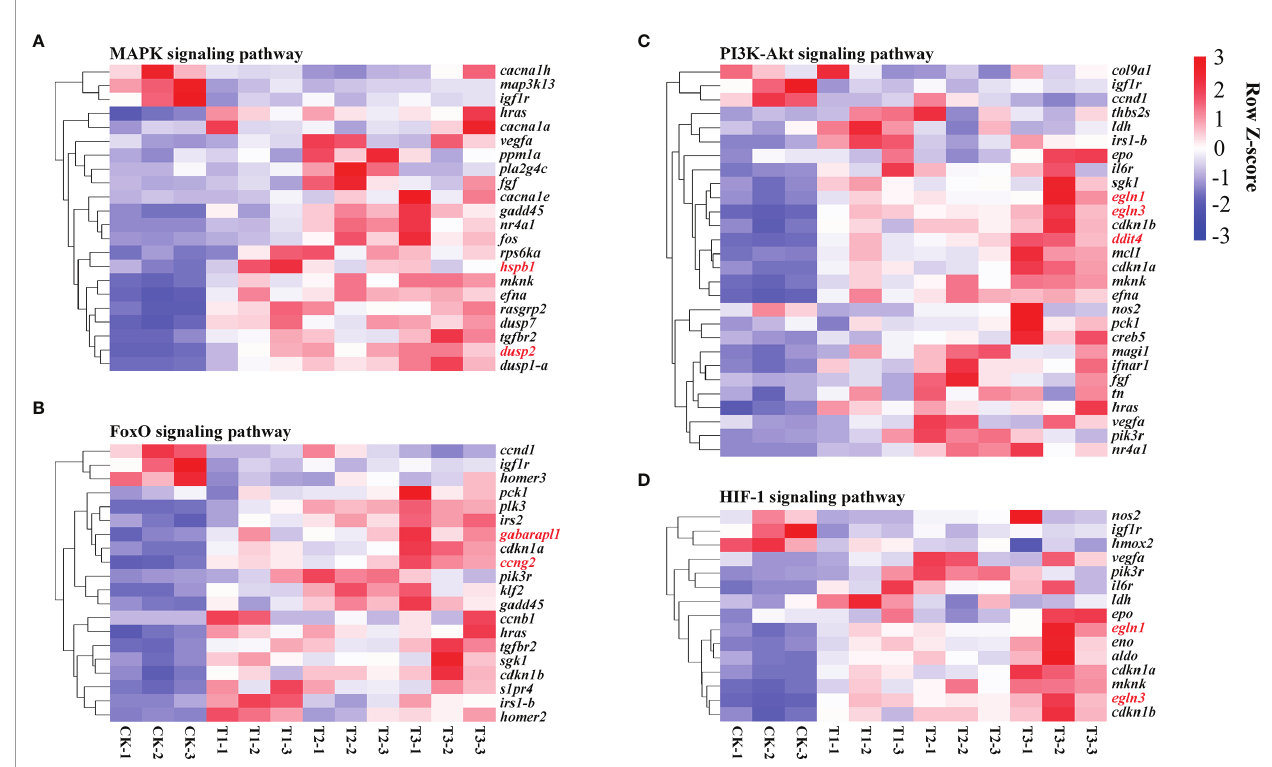
FIGURE 8 | Heat map exhibiting alterations in gene expression in the pathways related to oxygen transport, such as MAPK (A) , FoxO (B) , PI3K-Akt (C) , and HIF-1 signaling cascade (D) . The evaluation criteria used the average RPKM value per gene. Genes with contents greater than the mean are colored red, while those with contents below the mean are colored